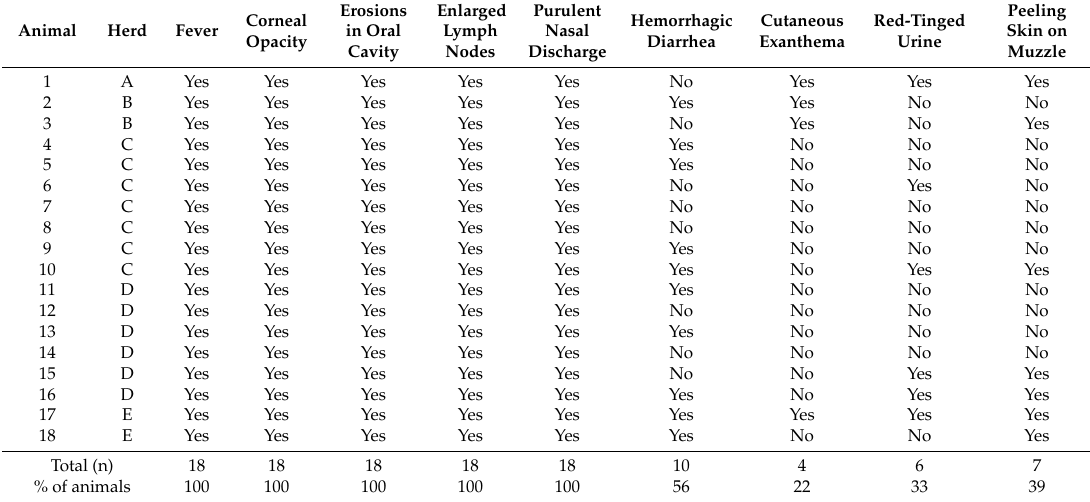
Table 2. Clinical signs seen in cattle in this study.